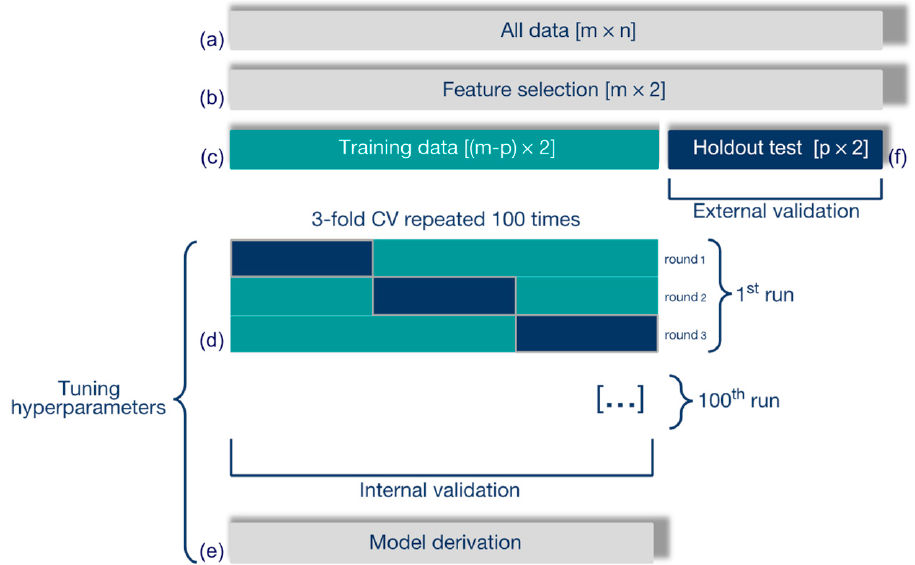
Figure 2. Development of the radiomic model to predict csPCa. ( a ) RFs are normalized and standardized, and ( b ) selected through LASSO. ( c ) A linear SVM classifier is trained and ( d ) 3-fold CV is performed for internal validation. ( e ) The final model is selected and ( f ) externally validated on the holdout test set.